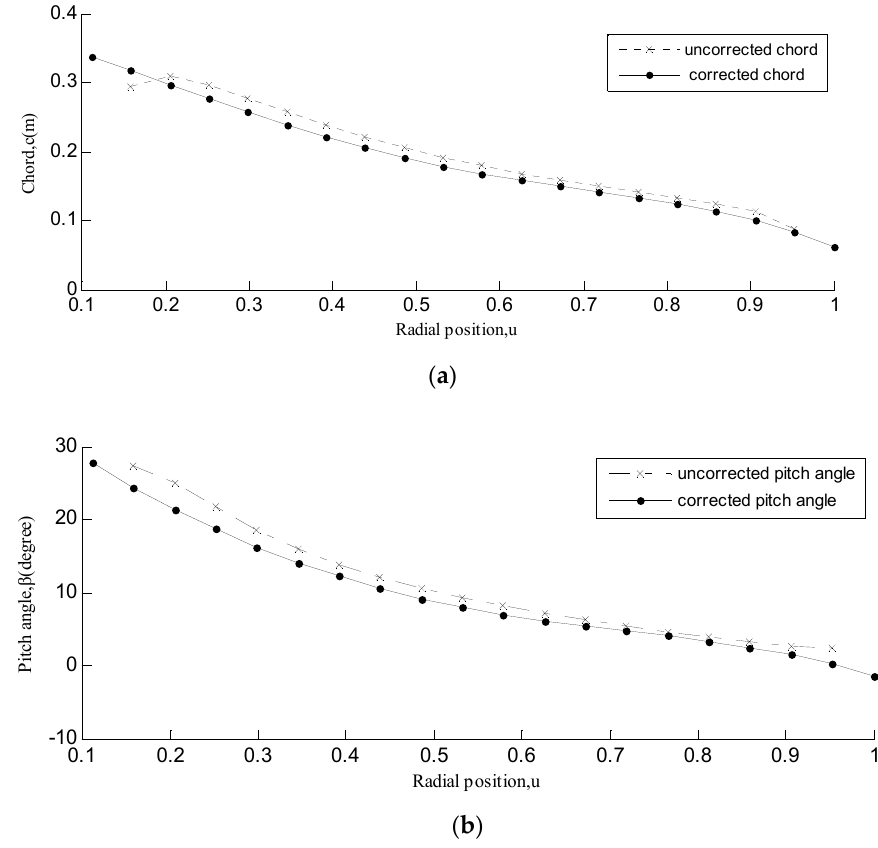
Figure 5. The geometry parameters of the blade; ( a ) chord length distribution, and ( b ) pitch angle distribution.